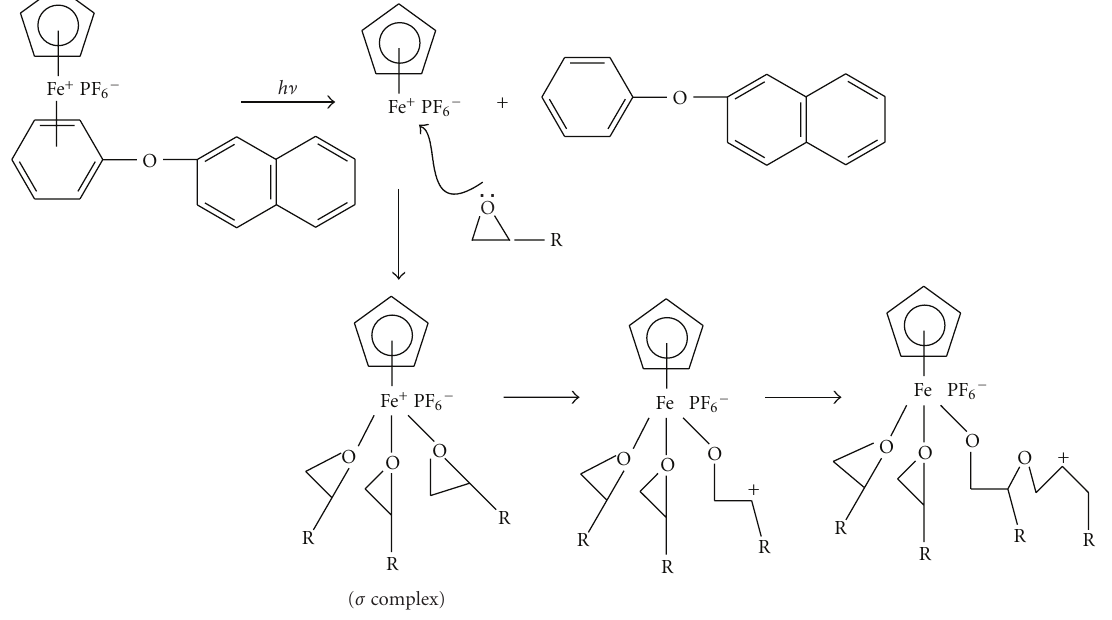
Scheme 3: Ring opening reaction of epoxide by an iron-arene